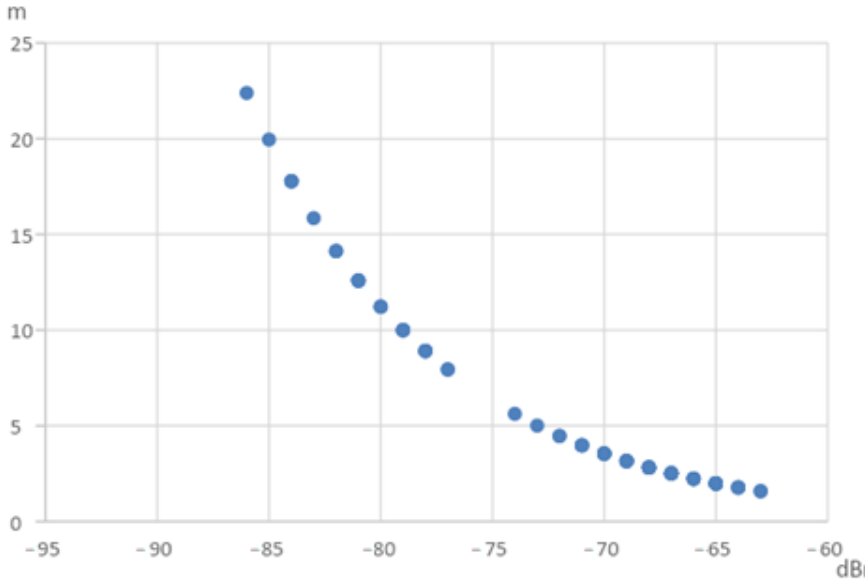
Figure 4. Bluetooth signal distribution diagram.